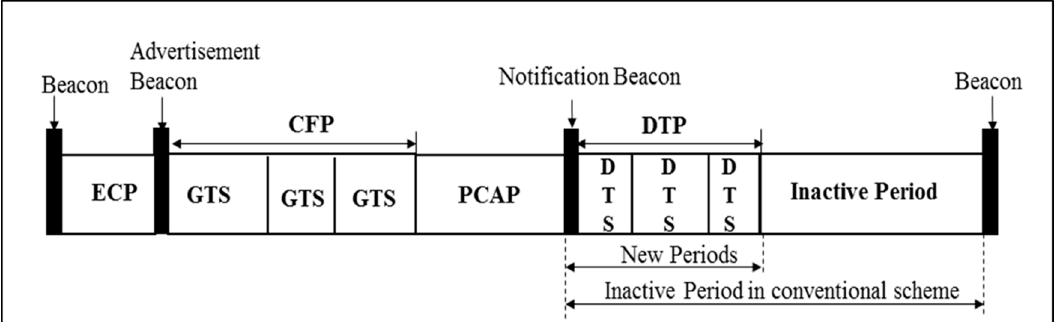
Figure 2. Modified Superframe Structure in the Proposed Protocol.